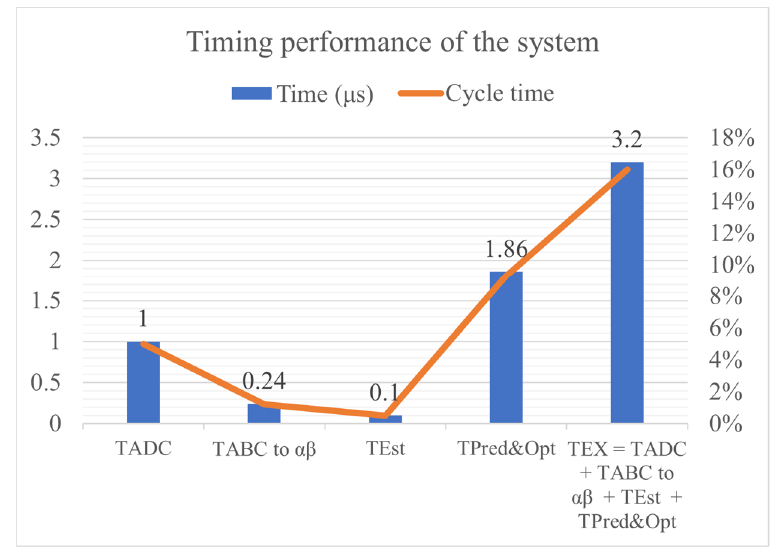
Figure 23. Graphical representation of the timing analysis for control implementation.